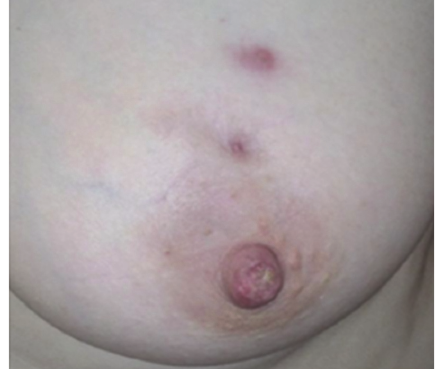
Figure 1: Left breast IGM 1.